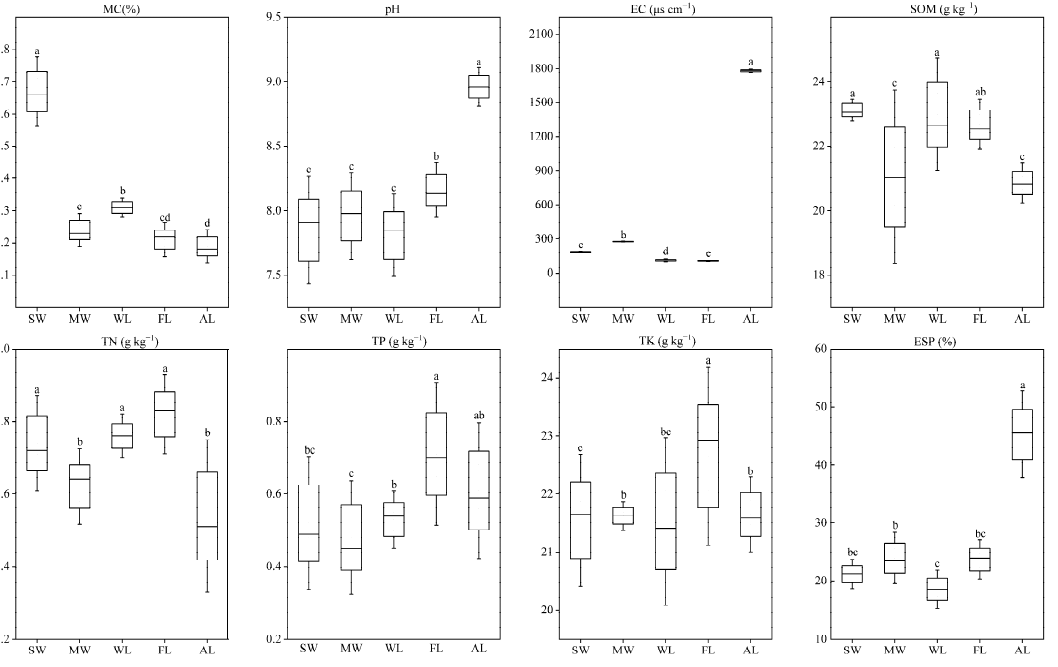
Figure 1. Soil characteristics under different land-use types. Different letters indicate a significant difference among different treatments ( p < 0.05). MC, moisture content; SOM, soil organic matter; TN, total nitrogen; TP, total phosphorus; TK, total kalium; ESP, exchange sodium percent. SW, swamp wetland; MW, meadow wetland; WL, woodland; FL, farmland; AL, alkaline land.